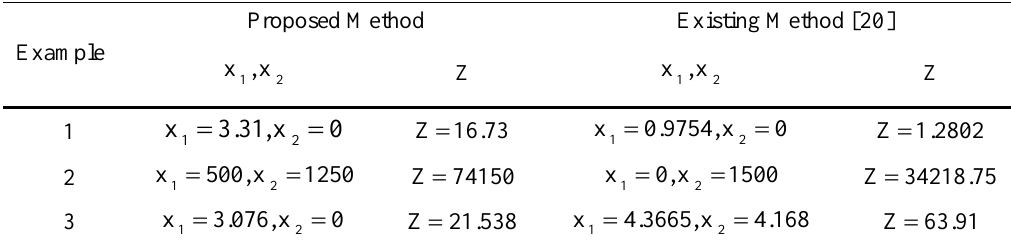
Table 1. Comparative of NLP problem using proposed method and existing method [20].